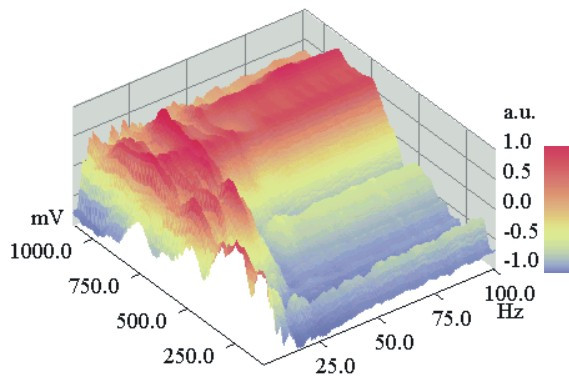
DNLDS resolved voltammogram dataset (normalized to spectral axis):Normalizations of the DNLDS resolved voltammogram dataset (sinewave 2 Hz with amplitude rising from 100–1100 mV, details of gaining data see text) of a Glutamic acid / HCl solution (2.24 mM, pH 2.85) under ICR Conditions (Bdc = 40 μT, Bac = 50 nT, 4.14 Hz). Datapoints are colored resp. shaded according to the scale on the right border. Normalization of the spectra for each Amplitude shows a rising proportion of higher frequencies with a local (at about 500 mV) and a total maximum (at about 700–800 mV). By contrast, the proportions of the base frequency (2 Hz) and the lower harmonics decline.